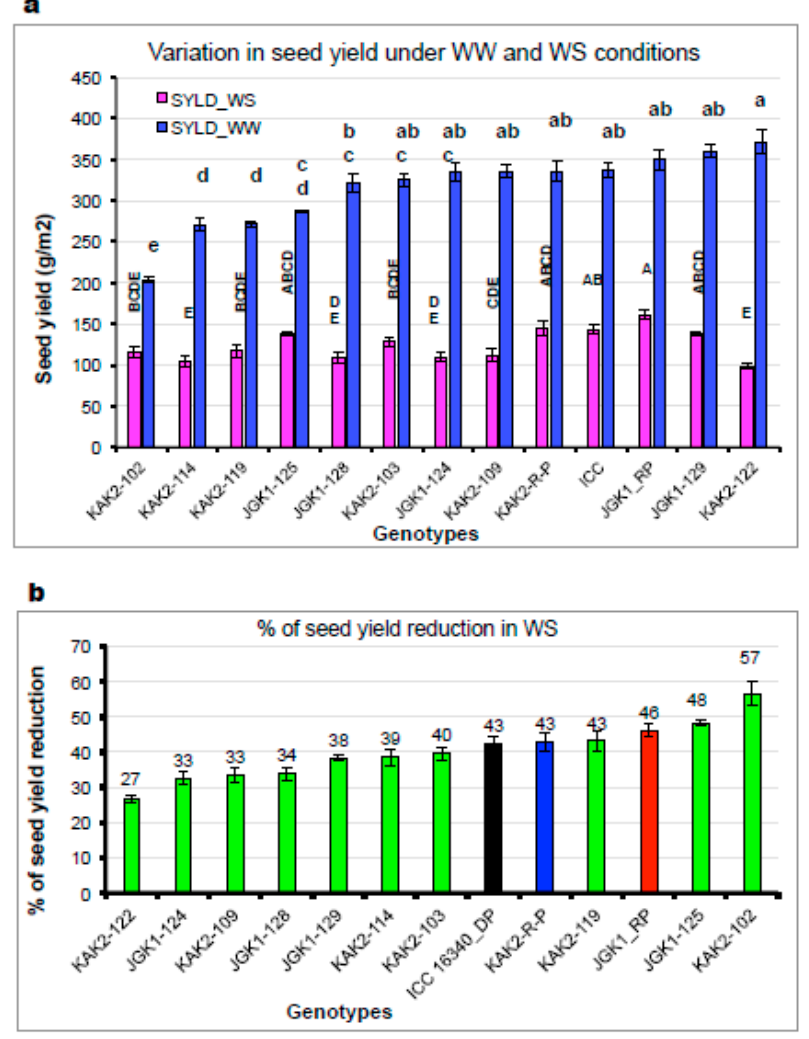
Figure 8. ( a ) Variation in seed yield under well water (bar filled with blue colour) and water stress (bar filled with pink colour) conditions. The data used for these bar graphs are mean data, obtained under well-watered (WW) and water stress (WS) conditions. For each genotype, three replicates data points were used to draw the bar graph. Bars with di ff erent capital letters (well-watered—WW) and small letters (water stressed—WS) alphabets are significantly di ff erent ( p < 0.05) and same